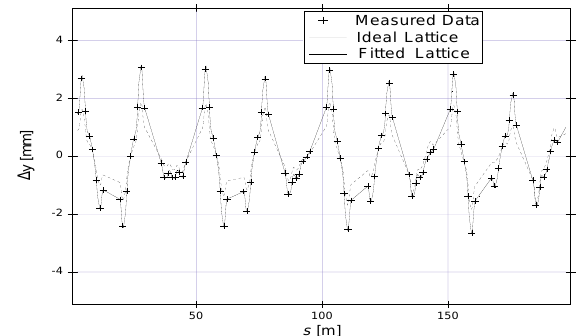
FIG. 3. A comparison of 1 column of the response matrix (+) with the ideal lattice and with the lattice after fitting.